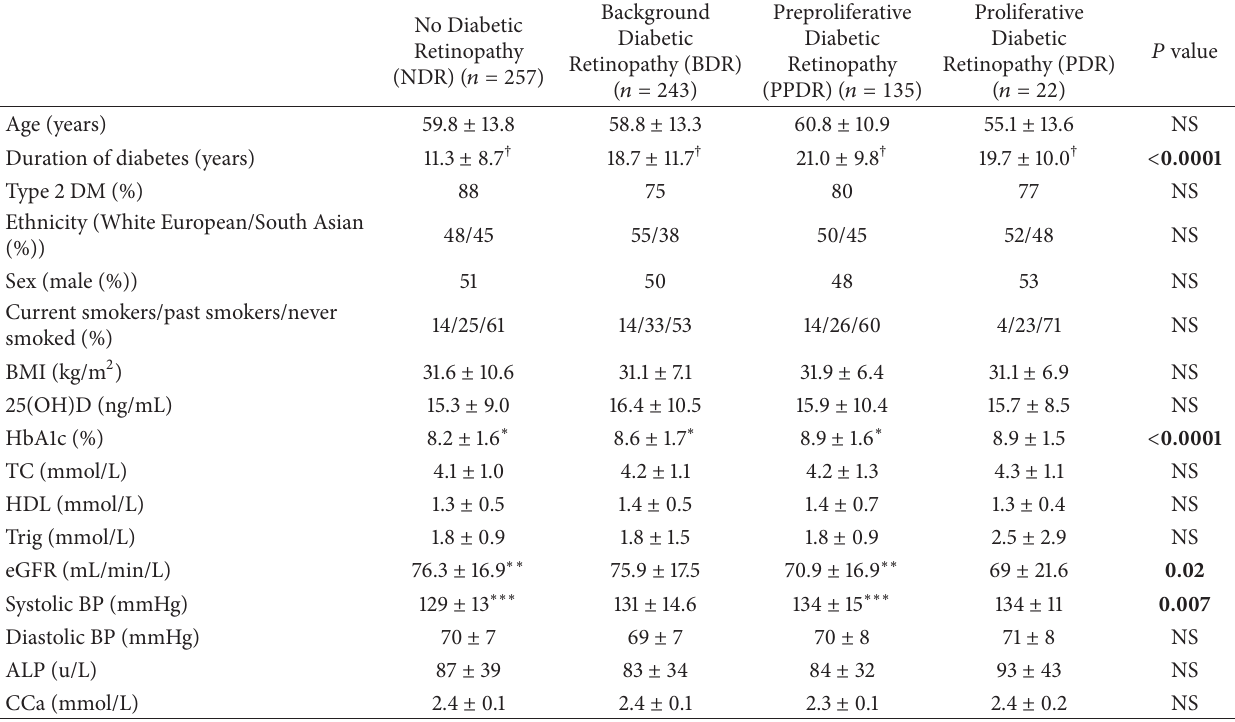
Table 1: Demographic and metabolic parameters in subgroups based on severity of retinopathy.